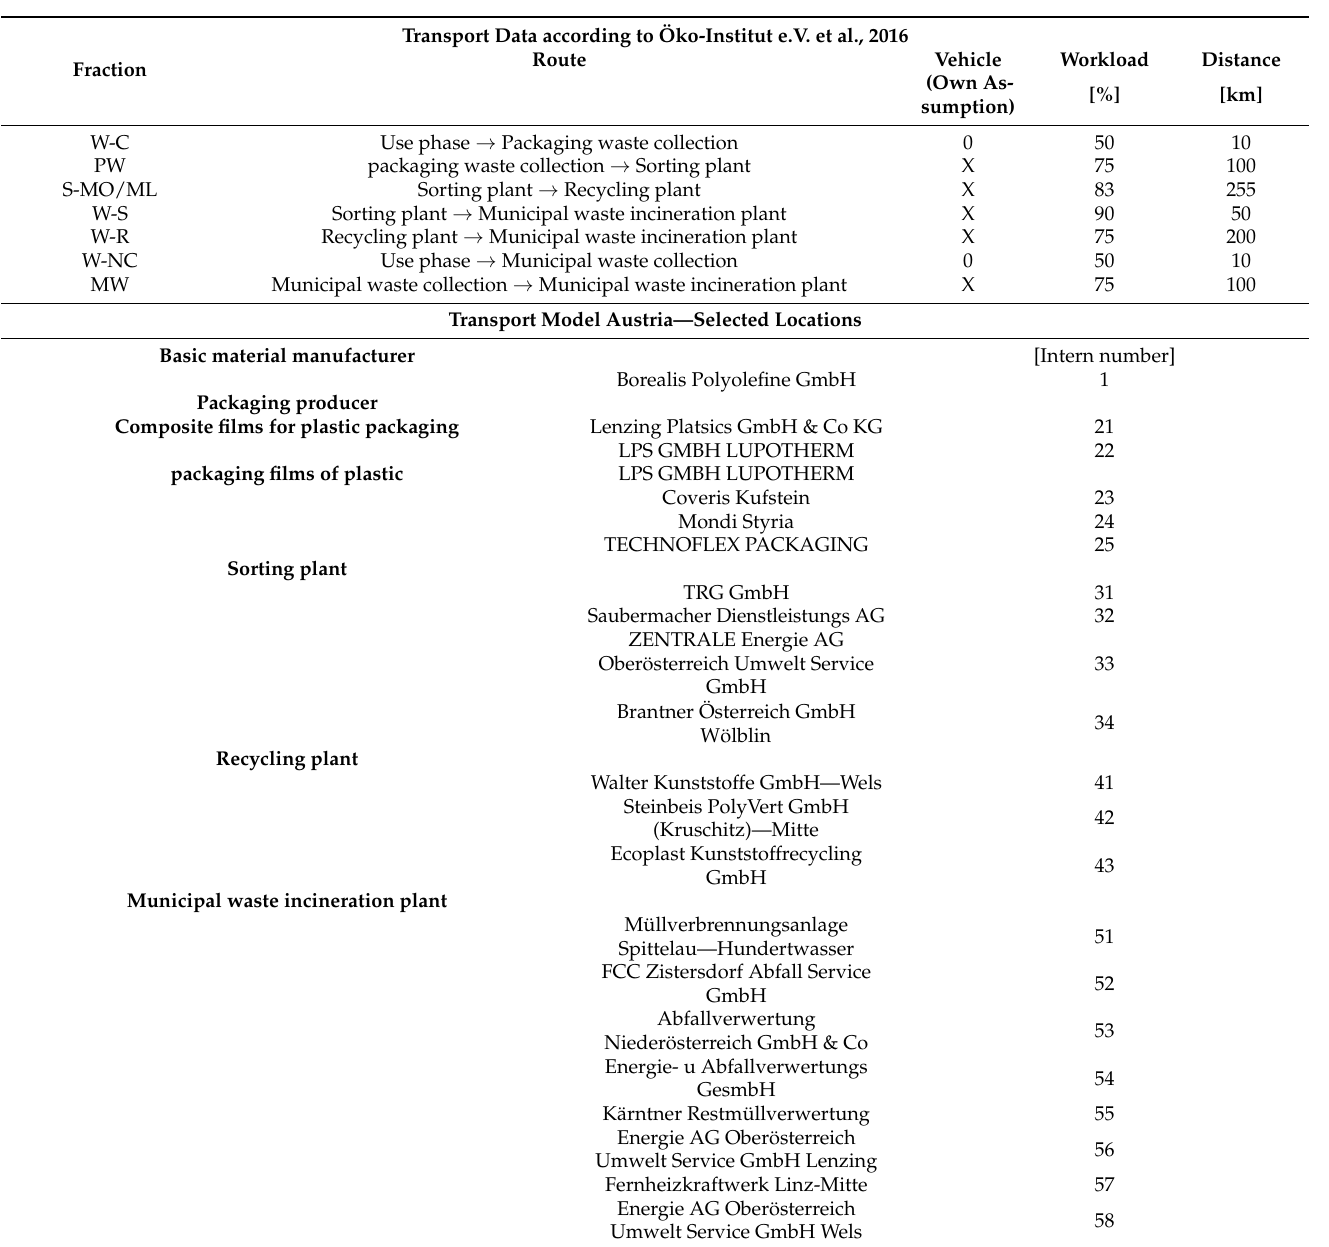
Table A7. Data basis and evaluation of the transport model. 0 GLO: Truck, Euro 5, 14–20 t gross weight/11.4 t payload capacity (GaBi); X GLO: Truck-trailer, Euro 0–6 mix, 34–40 t gross weight/27t payload capacity (GaBi)